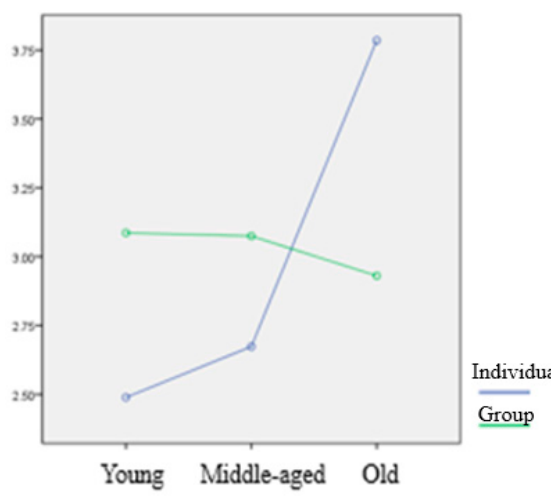
Figure 2. Interaction effects of Thanatophobia.